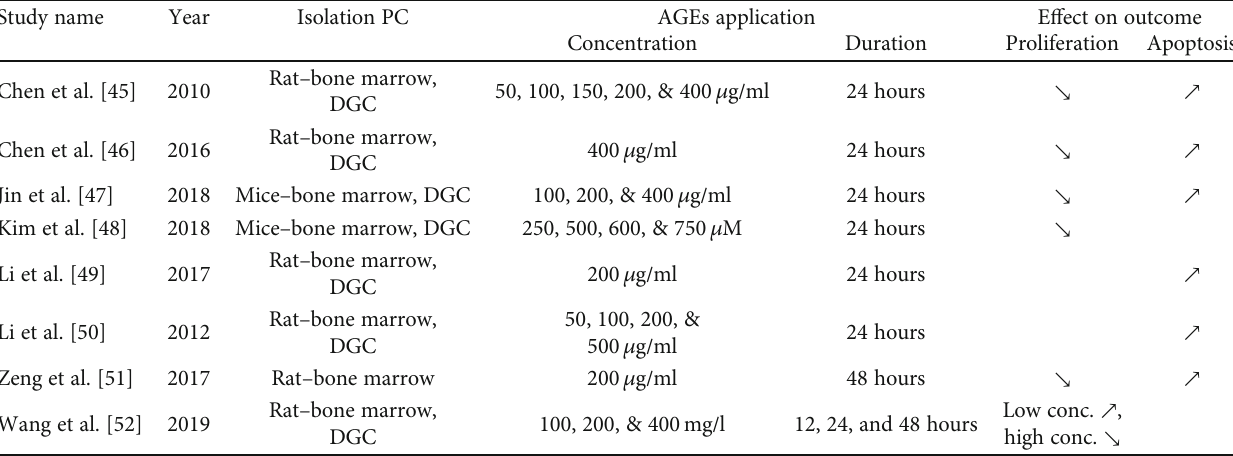
Table 2: Summary of included studies using EPCs isolated from the bone marrow. Summary of the isolation procedure and sampling, AGEs concentration, application duration, and e ff ect on outcome measurement proliferation and